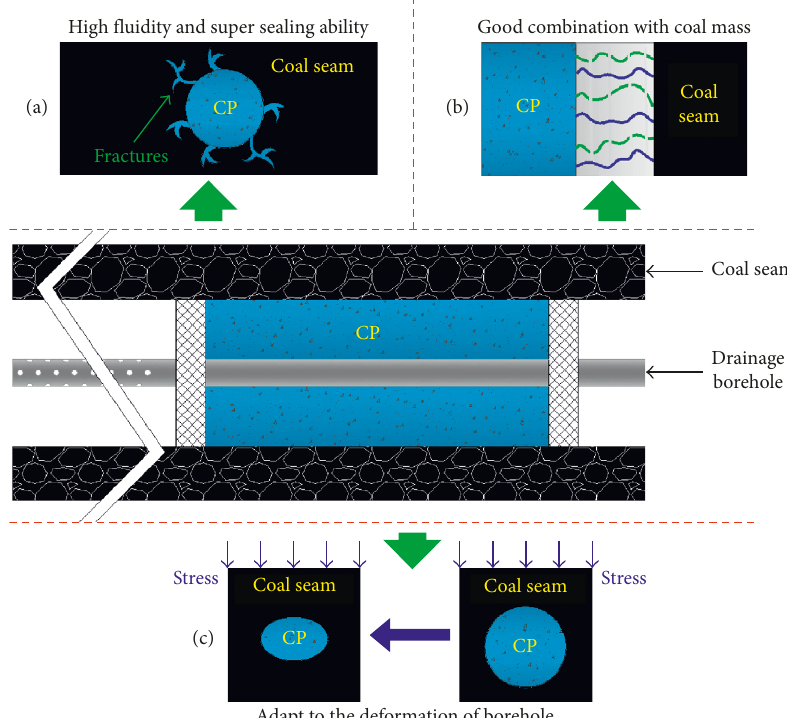
Figure 8: Sealing performance of CP